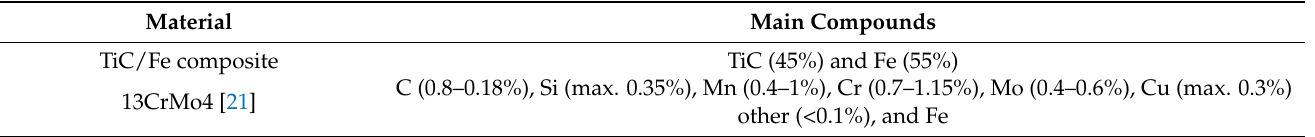
Table 1. Chemical composition of the